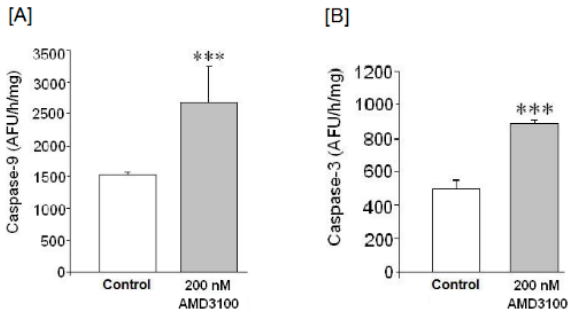
Figure 3. Effect of AMD3100 on ( A ) caspase-9 activity; ( B ) caspase-3 activity. Results are expressed as means ± SEM of two experiments from different cultures, each one performed in triplicate with different batches of cells. The statistical significance was evaluated by t- Student test using Sigma Plot 11 software. Differences were considered significant at p < 0.05. The asterisks indicate statistical significance as compared to controls, *** p < 0.001.